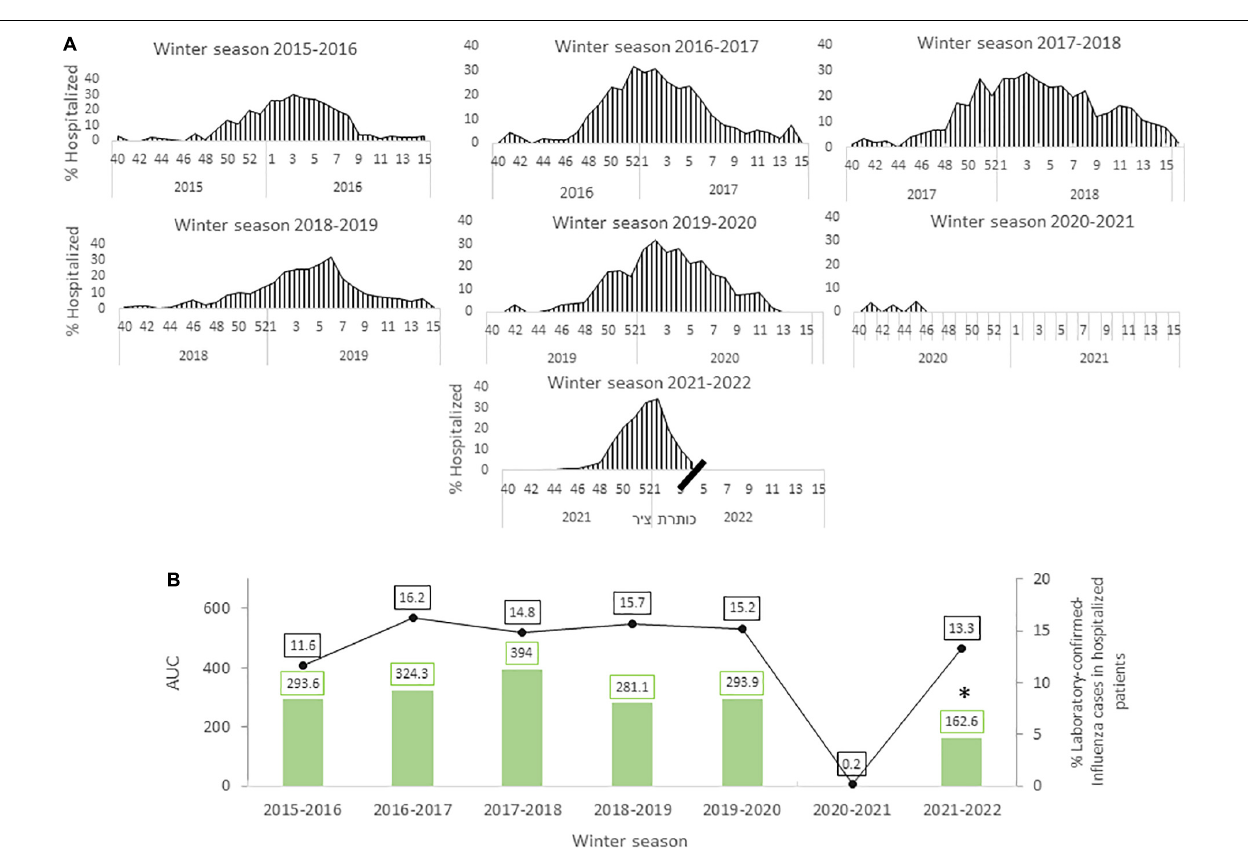
FIGURE 2 | Circulation of influenza from week 40 to week 15 the following year for each winter season between 2015 and 2022. A comparison of the area under the curve (AUC) from winter season 2015 to winter season 2022 (A) . The percentage of influenza-positive cases among hospitalized patients in each winter season (green columns) alongside the total number of hospitalized patients tested for influenza in each year (black line). ∗ p < 0.0017 (B)